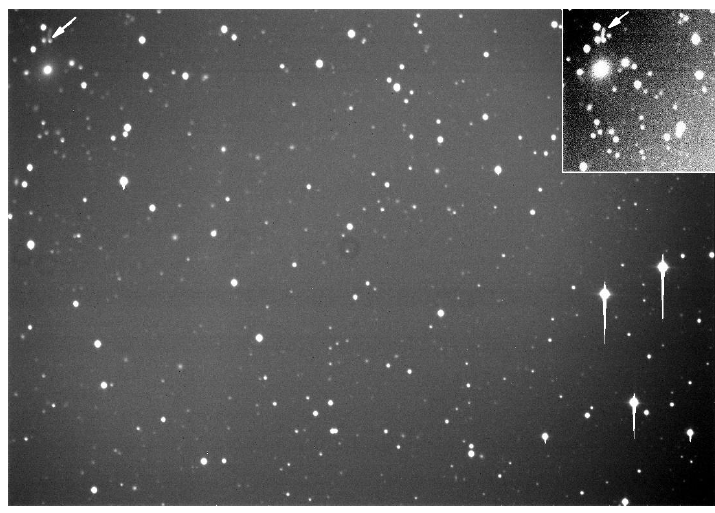
Fig. 1. Discovery image of the Apollo group asteroid 2008 OS9. The size of the field is 9 ′ (cid:2) 13 ′ (the insert at the right top corner is 3 ′ (cid:2) 3 ′ ). The exposure time is 8 min. Taken at the Baldone Observatory (Latvia) on the night 2008 July